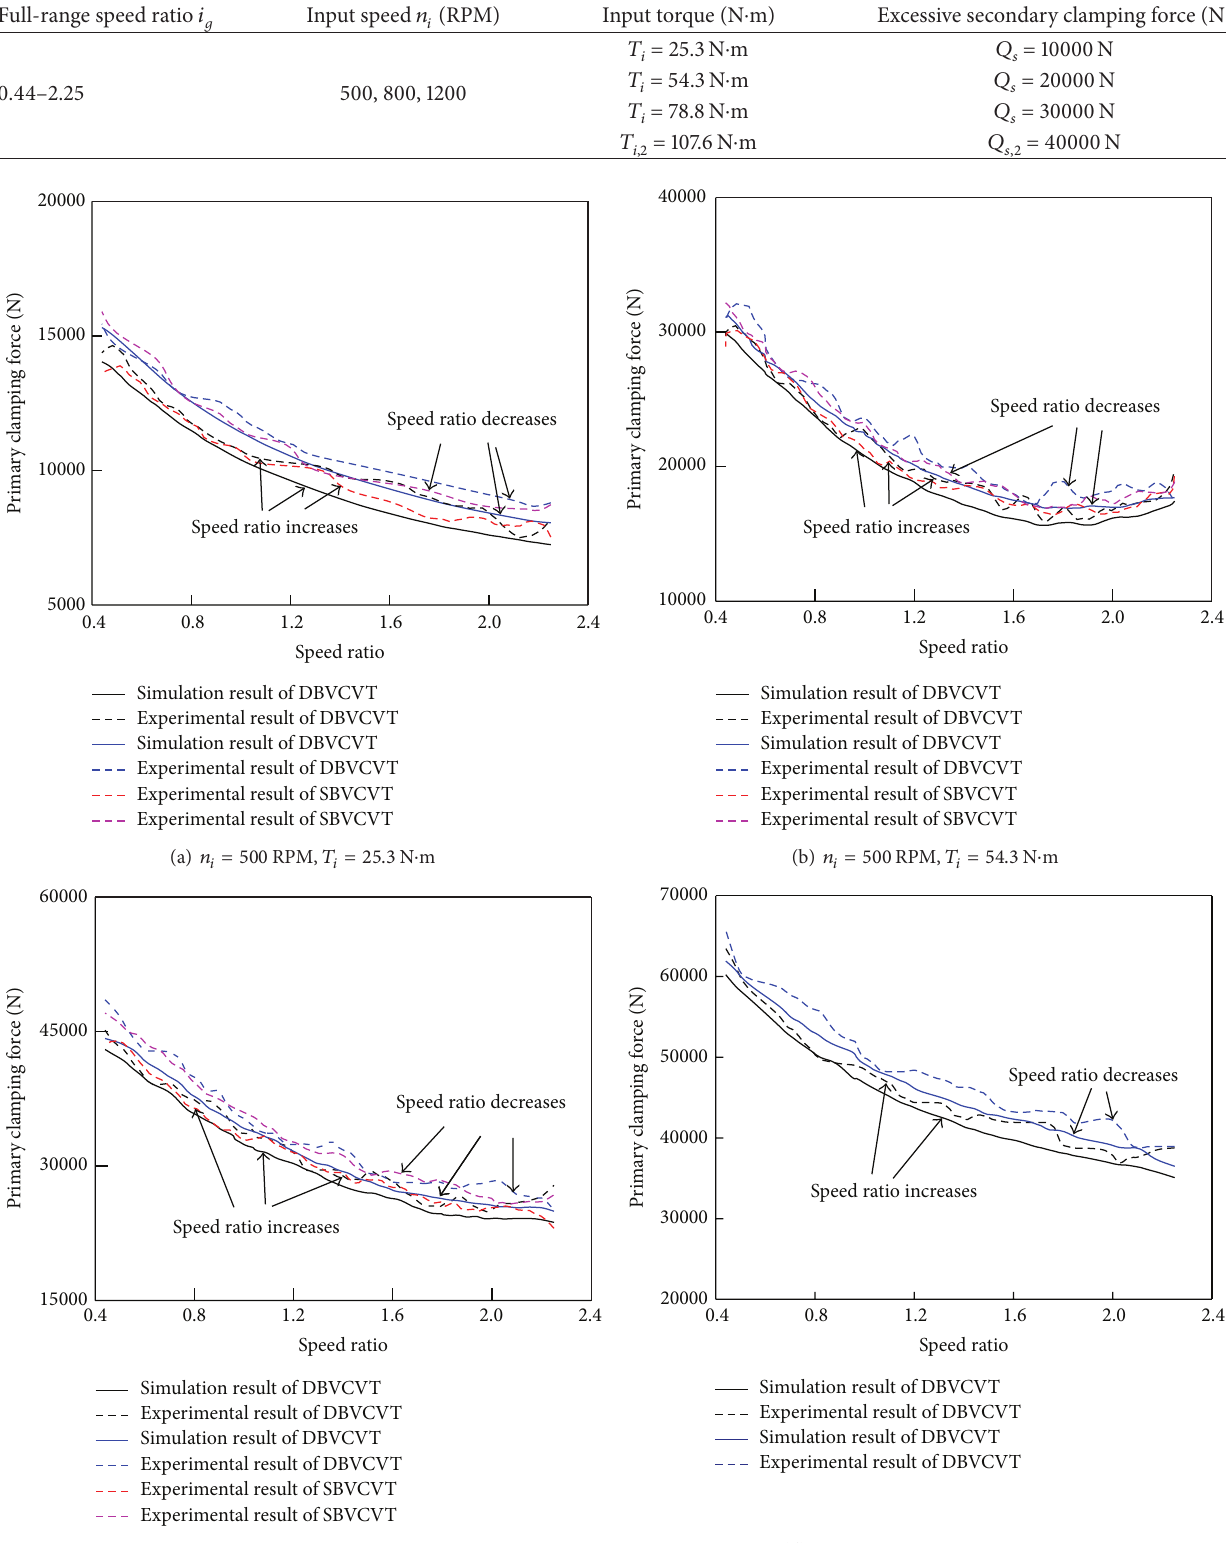
Table 2: Test conditions.